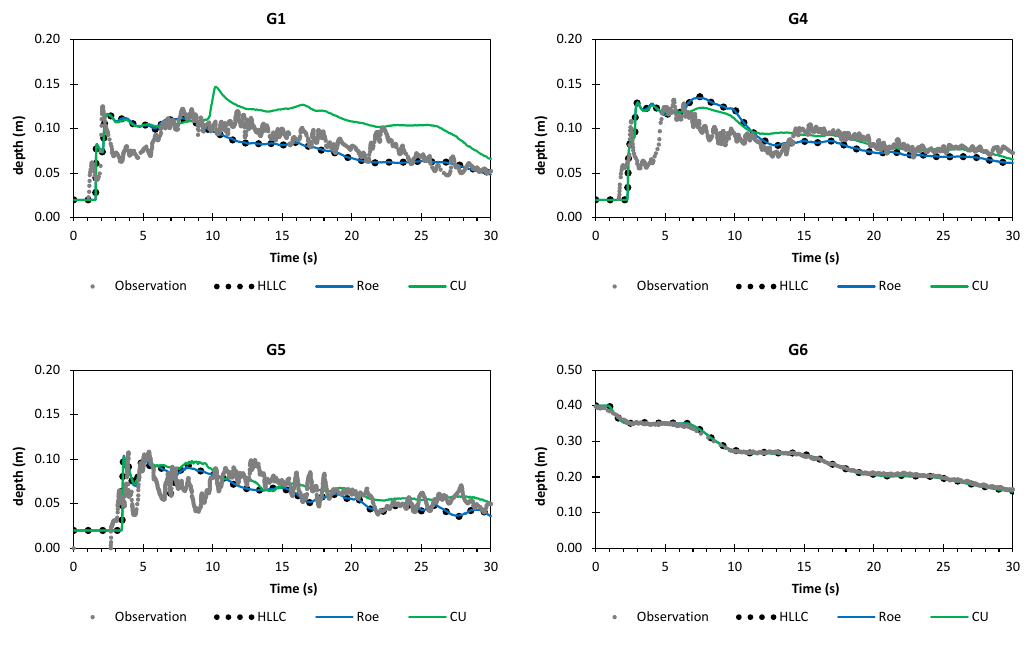
Figure 9. Case 2: comparison of depths between observation and numerical